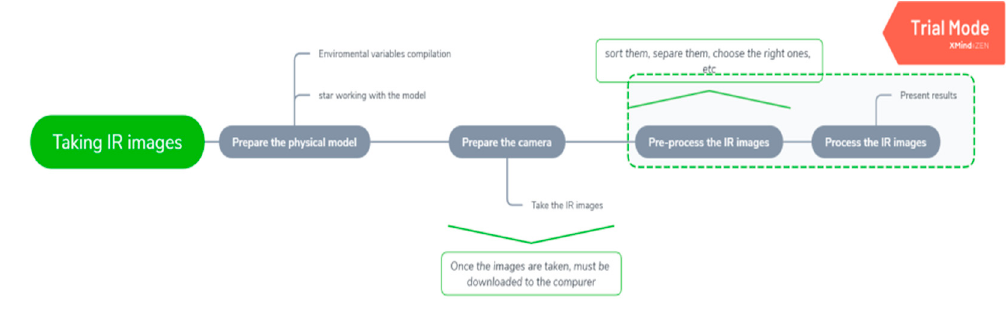
Figure 2. Process followed for taking images on the laboratory